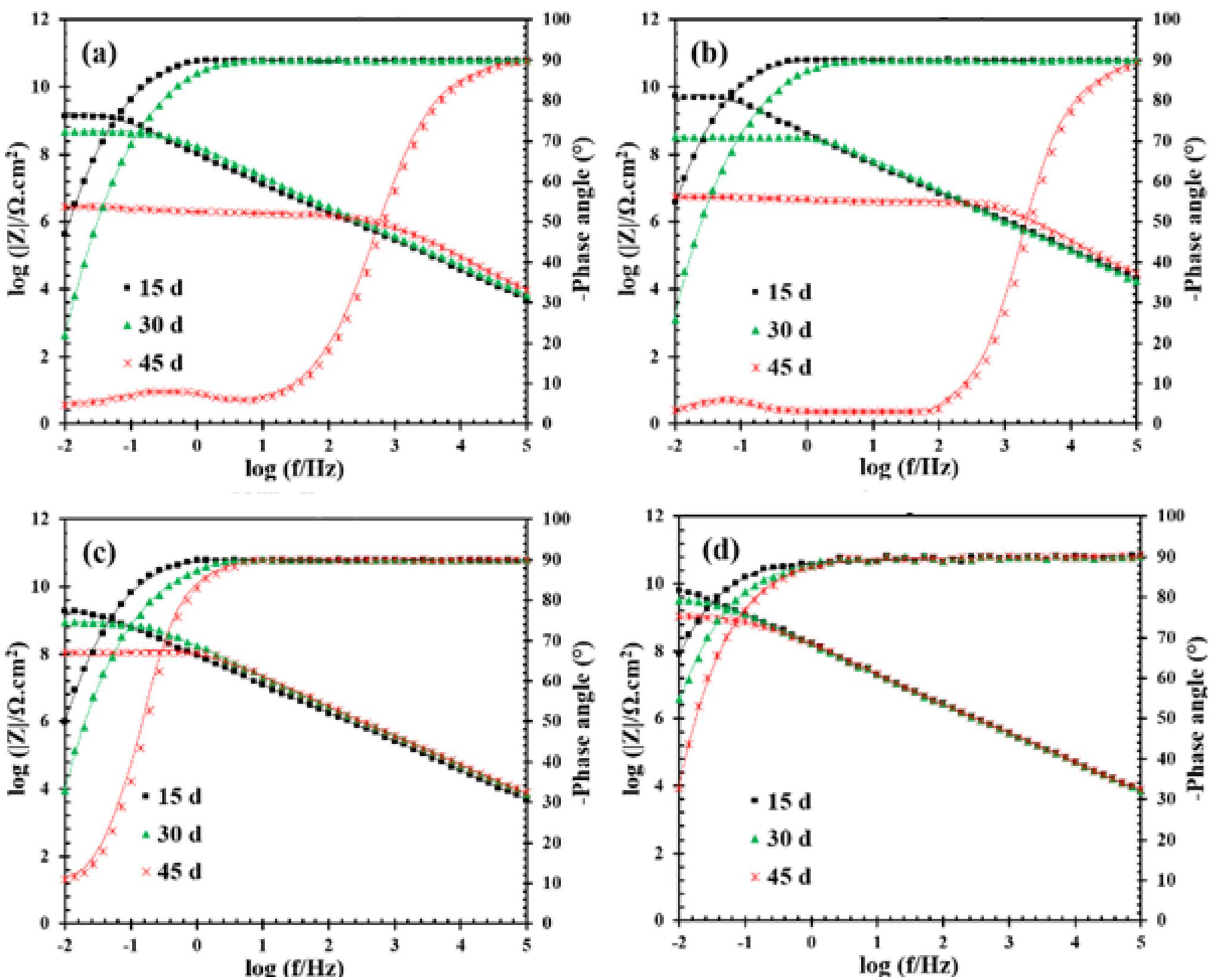
Figure 4. Bode plots of ( a ) unmodified/epoxy, ( b ) UiO-66-NH 2 /epoxy, ( c ) CNTs/epoxy, and ( d ) composite